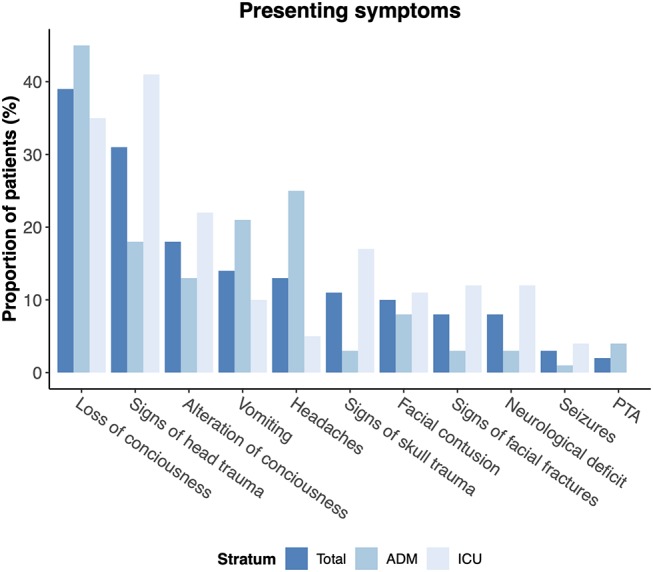
Presenting symptoms of pediatric patients with TBI. PTA: Post-traumatic amnesia.